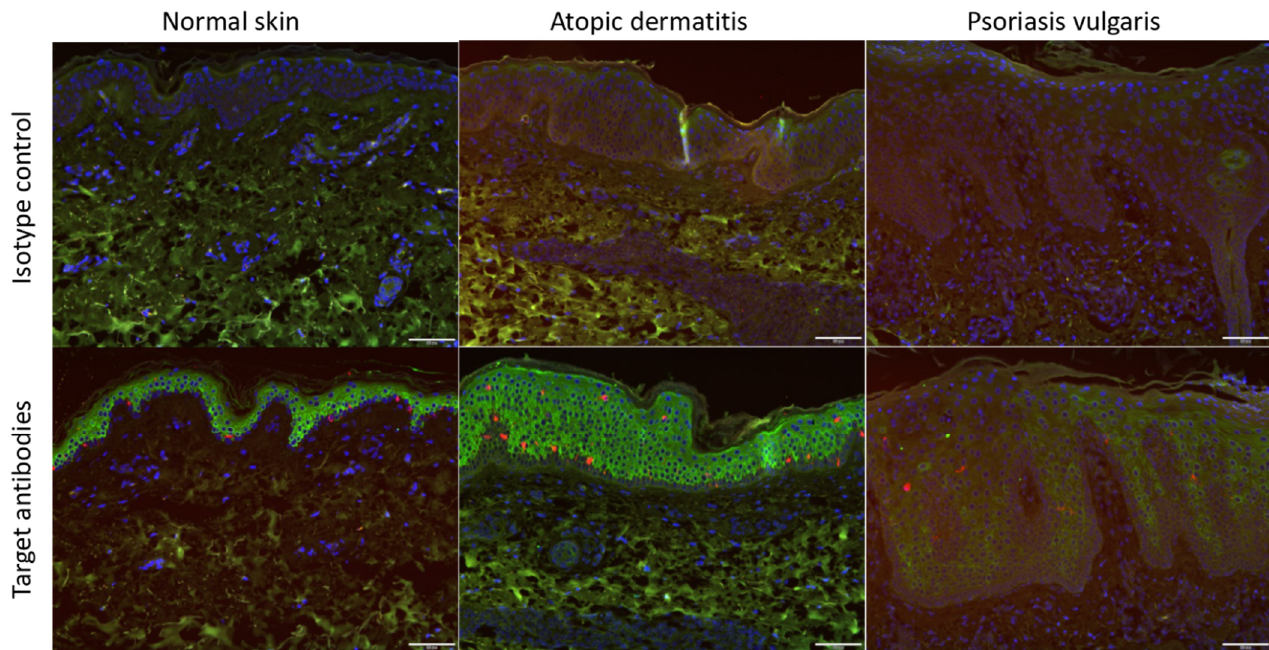
Figure 1. The ACE expression is increased in AD skin compared with that in psoriatic skin and healthy skin. We performed immunohistochemistry on the skin from psoriatic, atopic, and healthy patients. The ACE2 receptor (green color) was expressed in the basal and suprabasal epidermis in all three disease conditions. Notably, the ACE2 expression was increased in AD ( middle pictures) compared with that in normal skin ( left ) and psoriasis ( right ). Green: ACE2; blue: DAPI; red: CD207 (langerin), Langerhans cell. Representative images are shown.